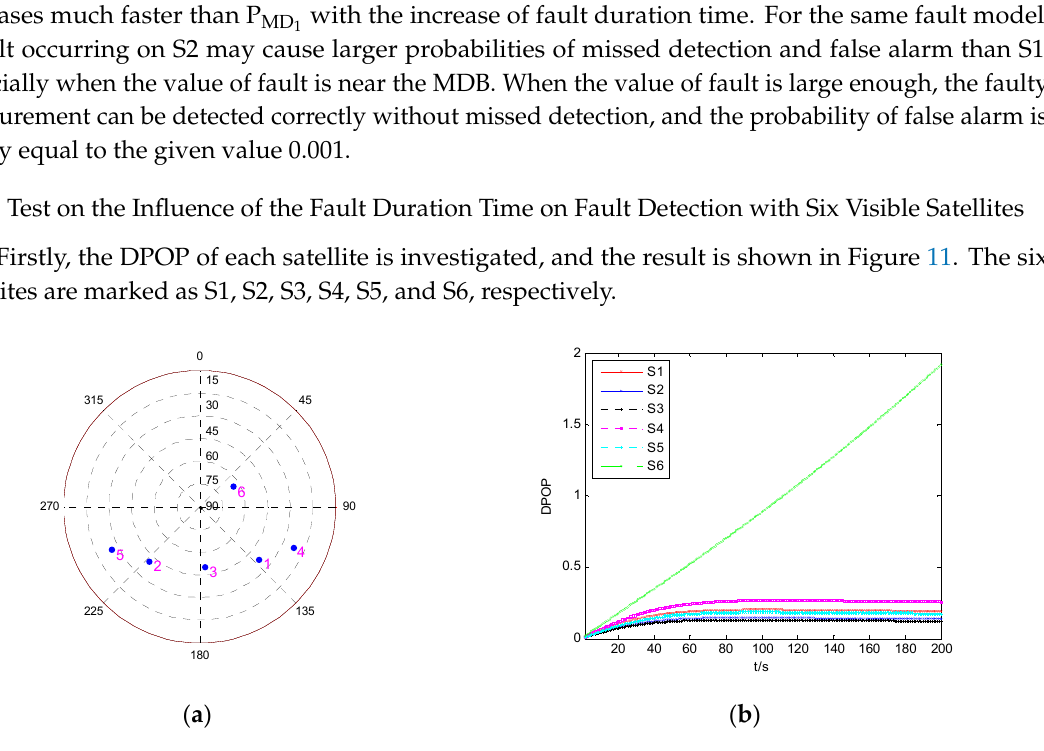
Figure 11. The geometry and DPOP of six visible satellites. ( a ) Sky plot view of the satellite geometry; ( b ) DPOP of each satellite as function of time.